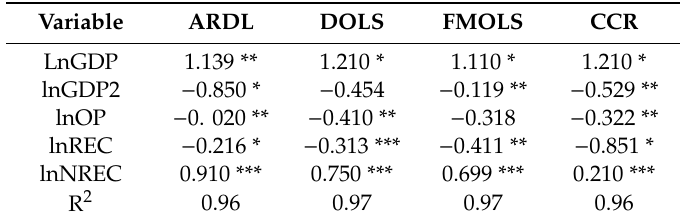
Table 6. Long-run coe ffi cients, ARDL, DOLS, FMOLS, and CCR models. Variable